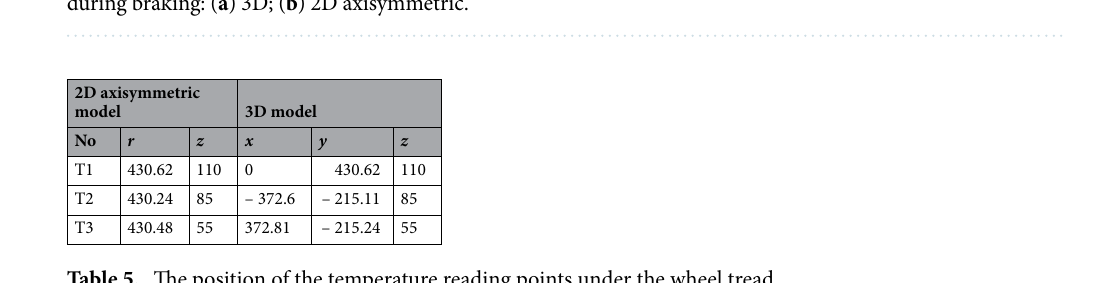
Figure 5. Second order (quadratic Lagrange) finite element meshes for simulation of frictional heat generation during braking: ( a ) 3D; ( b ) 2D axisymmetric.